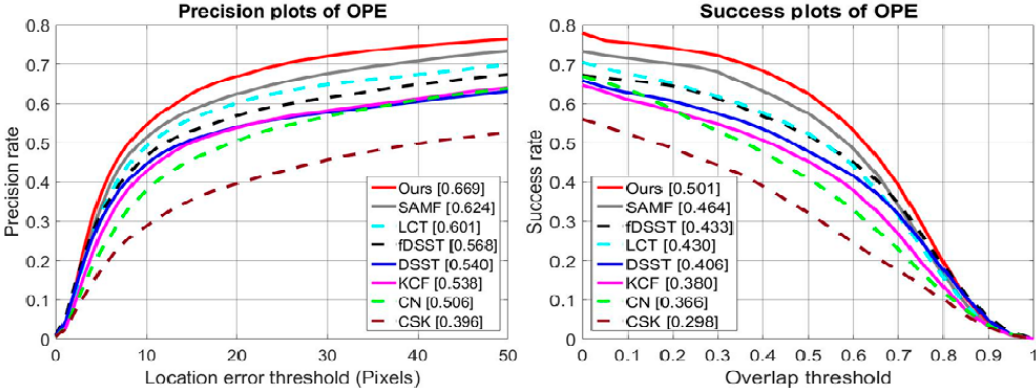
Figure 5. Precision and success plots on Temple Color-128.